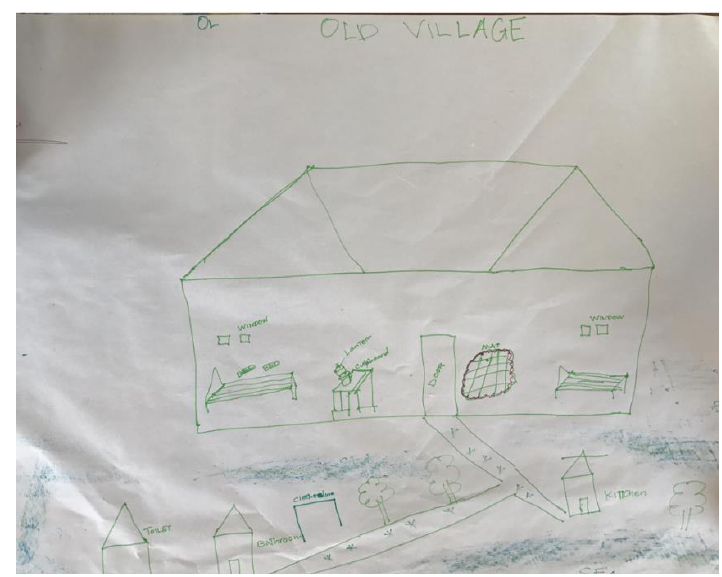
Figure 4. Focus group exercise showcasing water surrounding a home in the old site of Vunidogoloa village.